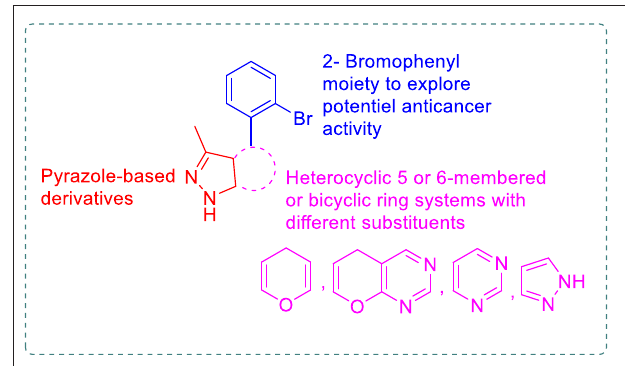
FIGURE 1 | The designed pyrazole-based target